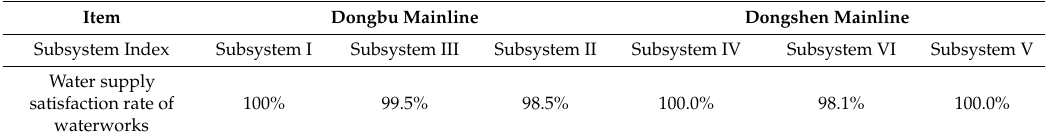
Table 9. The statistical values of the water demand satisfaction rate of waterworks for each subsystem.